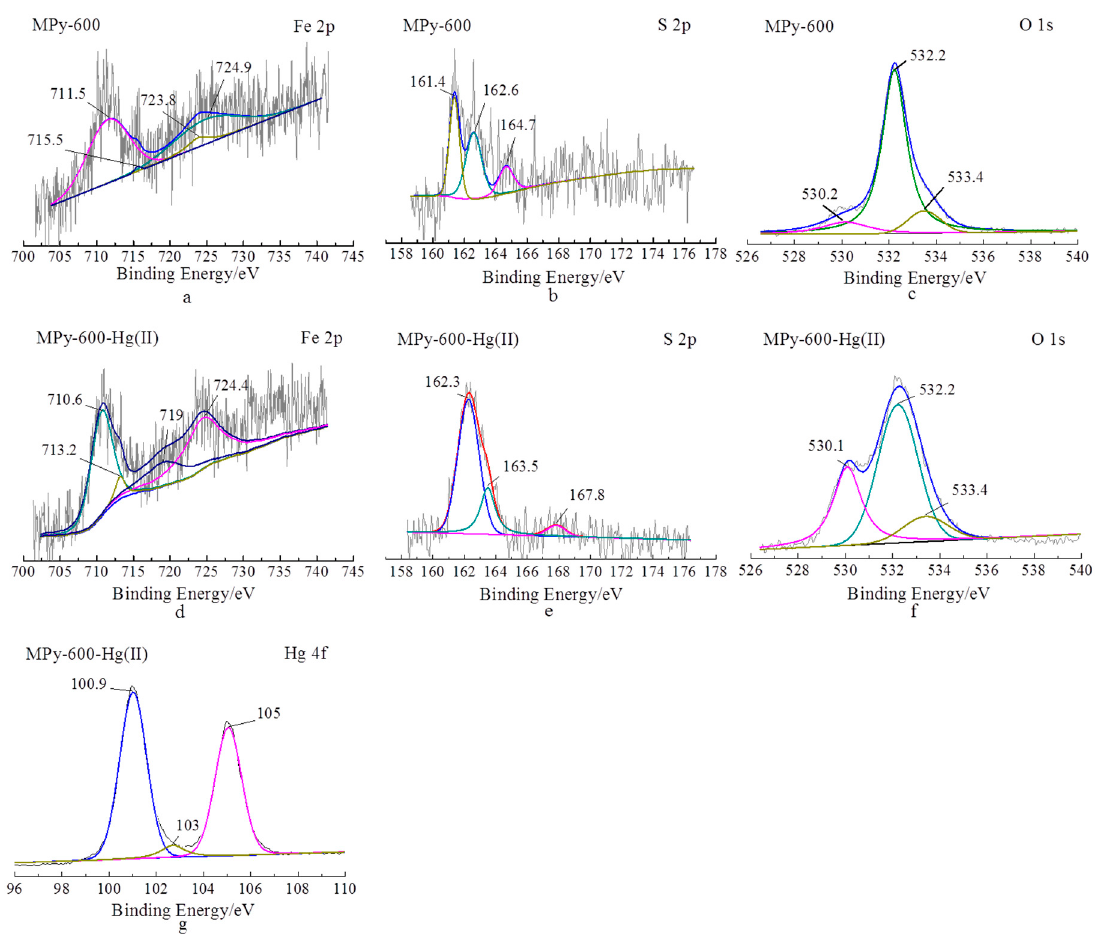
Figure 9. XPS spectra of MPy-600 ( a – c ) and MPy-600 after Hg(II) adsorption( d – g ) in the Fe 2p, O 1s, S 2p, and Hg 4f spectral regions.